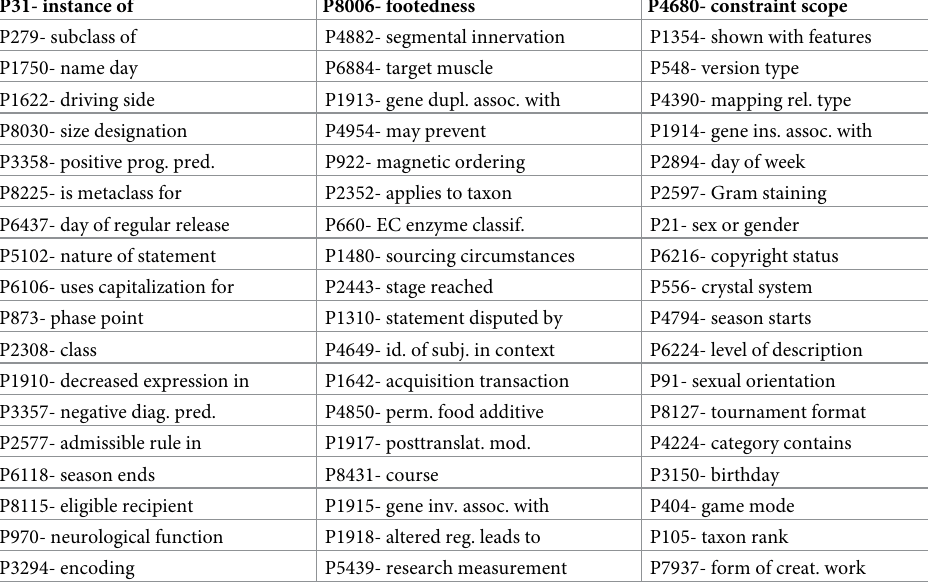
Table 4. Properties with a class ratio �